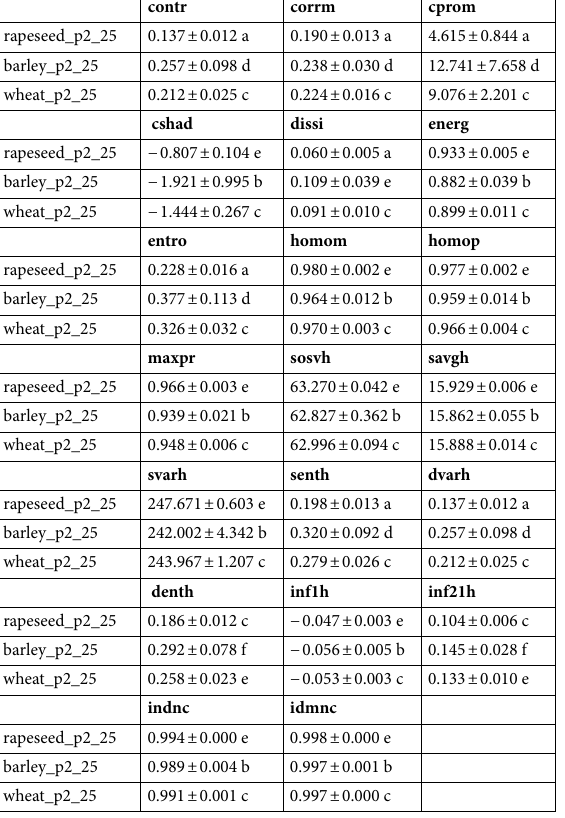
Table 8. Texture analysis of kernels for selected air stream velocities (25 m s −1 ) and the position of the seed-air tube of type II. a–e: the differences between mean values with the same letter in columns were statistically insignificant ( p <